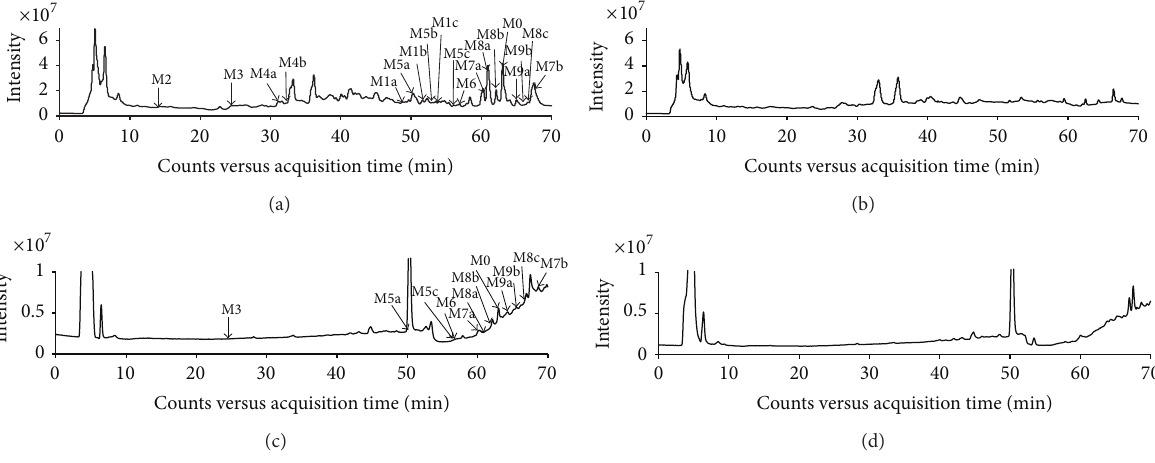
Figure 4: Total ion chromatograms (TICs) of rat urine and plasma samples by HPLC/Q-TOF/MS. (a) TIC of the urine sample after oral administration at a single dose of 50 mg/kg BG; (b) TIC of blank urine; (c) TIC of the plasma sample after oral administration at a single dose of 50 mg/kg BG; (d) TIC of blank